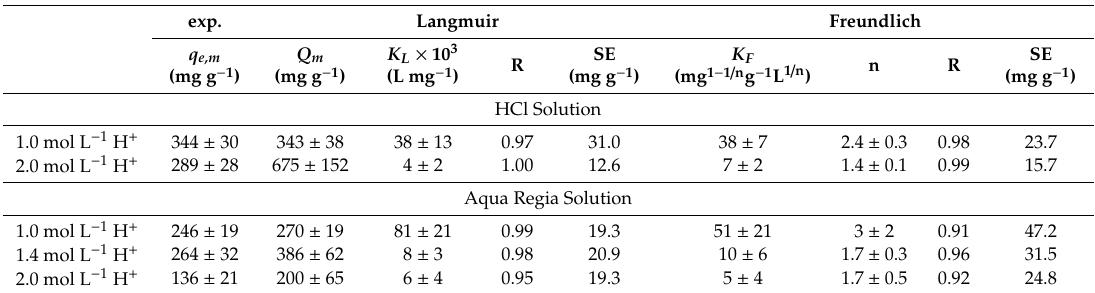
Table 1. Parameters of Langmuir and Freundlich isotherms for the adsorption of gold from HCl and aqua regia solutions using pine bark tannin resin, at 20 ◦ C, and comparison between the maximum adsorbed amounts obtained experimentally ( q e,m ) and from Langmuir modelling ( Q m ). exp. Langmuir Freundlich q e,m (mg g − 1